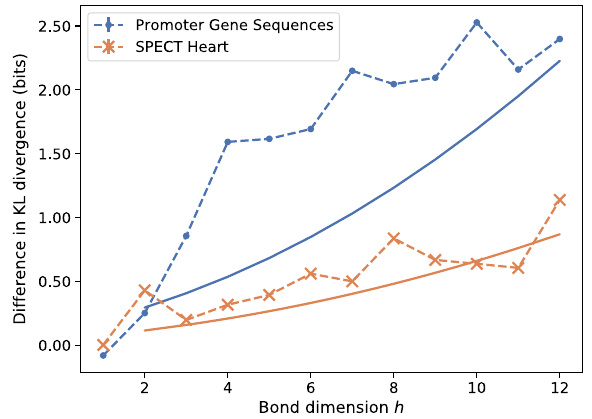
FIG. 8. Plotted with dashed lines are the improvements in KL divergence between the best-performing basis-enhanced 2-gram model and the best-performing classical hidden Markov model for each tested model size on the Promoter Gene Sequences and SPECT Heart data sets. The solid lines show the improvement needed to reject the null hypothesis in a likelihood-ratio test with 5 σ confidence (see Sec. V C). Wherever the dashed lines are above their corresponding solid lines, the null hypothesis was rejected with more than 5 σ